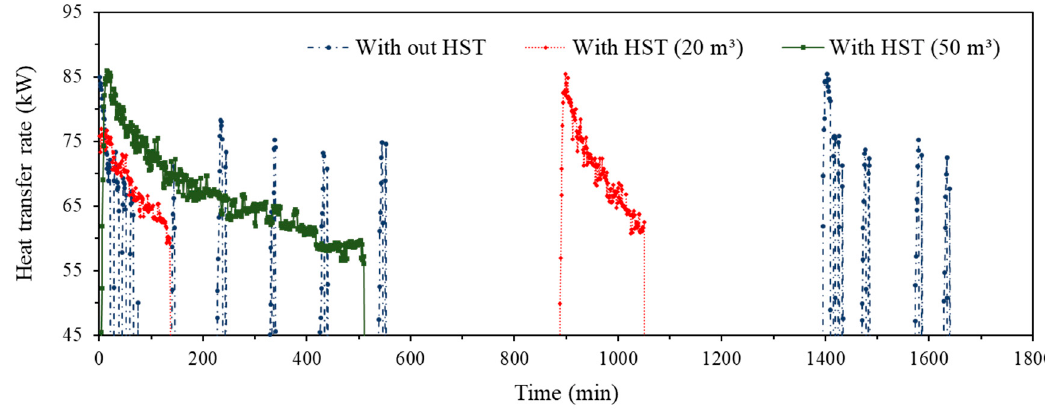
Figure 11. Heat exchange rate (HER) change according to the capacity of HST.